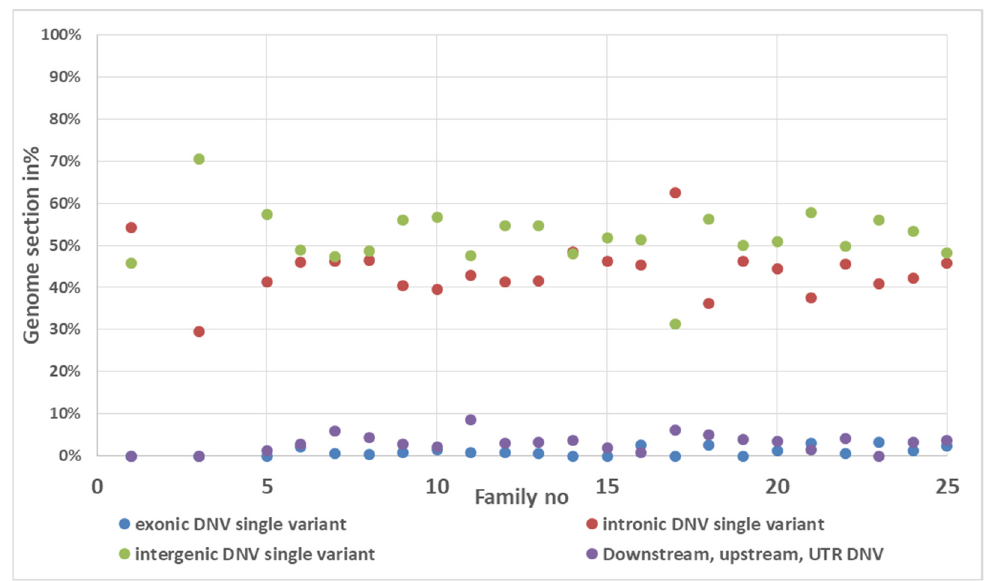
Figure 3. The distribution of de novo indels in genome regions according genome sequence func- tion.